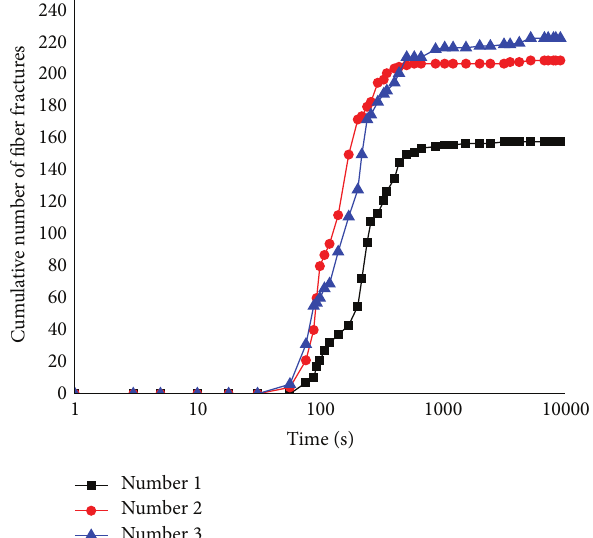
Figure 8: Change of cumulative number of fiber breakages with the tensile loading time in three specimens.